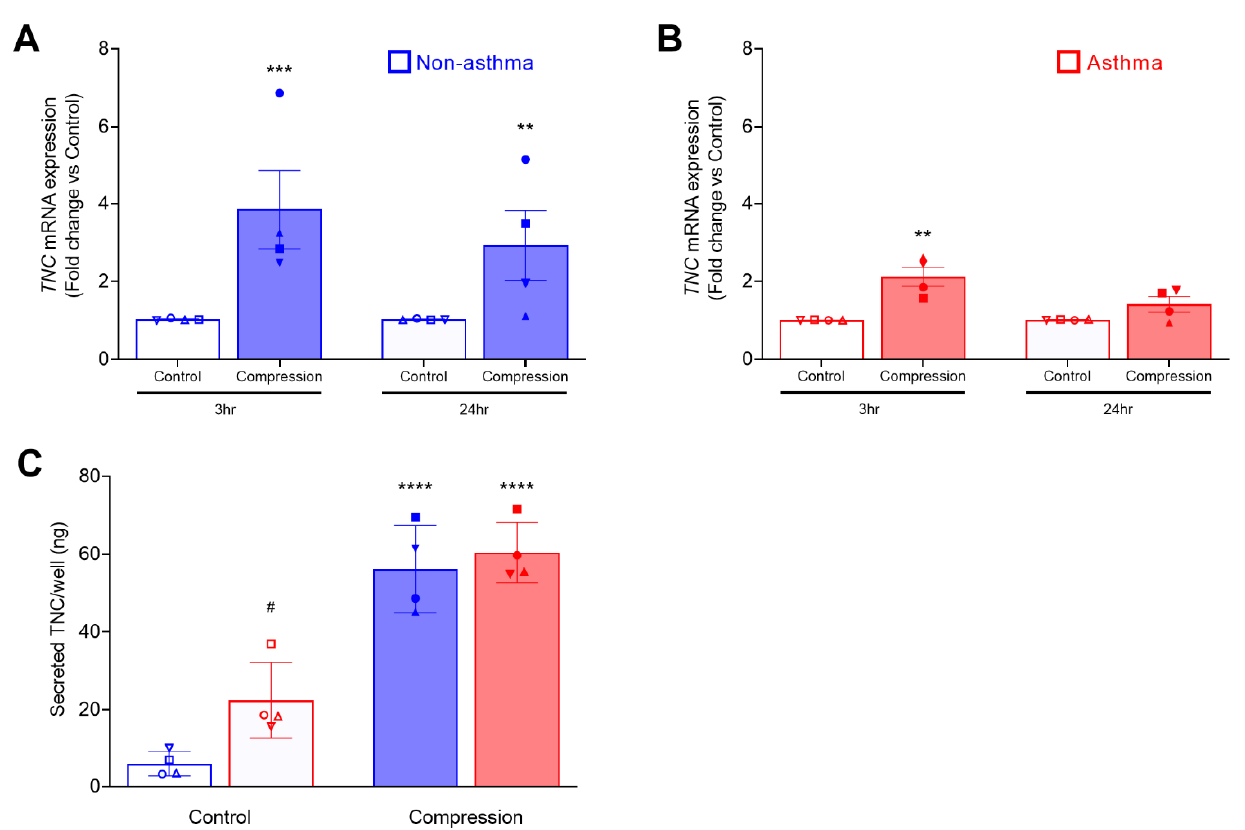
Figure 1. Mechanical compression induces mRNA expression and secretion of TNC from HBE cells. TNC mRNA expression was measured at 3 h and 24 h post-compression of non-asthmatic cells (mean ± SEM, 4 donors) ( A ) and asthmatic cells (mean ± SEM, 4 donors) ( B ). TNC mRNA expression was normalized to GAPDH . The amount/well of TNC secreted in the basolateral conditioned media was measured by ELISA (mean ± SEM, 4 non-asthma and 4 asthma donors) ( C ). ** p < 0.01, *** p < 0.001, **** p < 0.0001, significantly different from time-matched no pressure control, # p < 0.05 significantly different between non-asthma and asthma, analyzed by two-way ANOVA with Bonferroni’s post-hoc test. Each symbol represents each of the four donors. The open symbols represent control condition, and the closed symbols represent compressed condition in both non-asthmatic (blue symbols; A and C ) and asthmatic HBE cells (red symbols; B and C ).